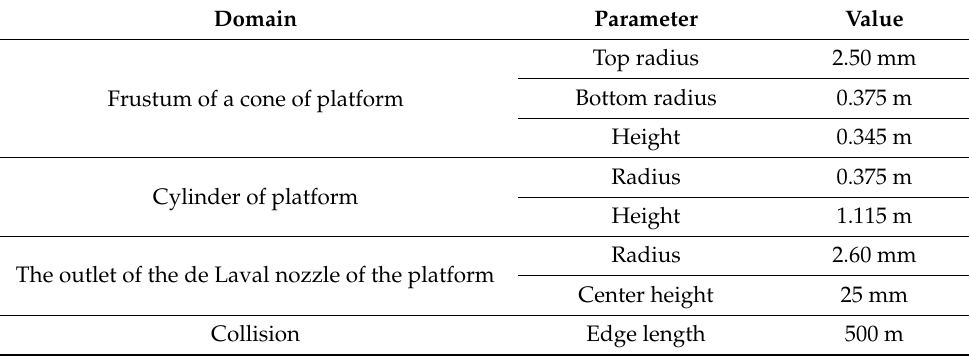
Figure 5. Structure of the model: ( a ) the sounding rocket platform; ( b ) the sensor sampling port of the mass spectrometer for in-situ atmospheric detection; ( c ) the outlet of the de Laval nozzle for the attitude control jet, which is the blue area; and ( d ) the collision domain used to simulate the collision process. Table 2. Geometric parameters of the model.